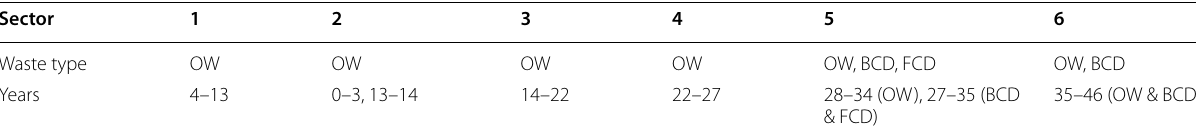
Table 1 Landfill sectors (1 to 6), landfilled wastes (OW, BCD and FCD) and landfilling years in each sector Sector